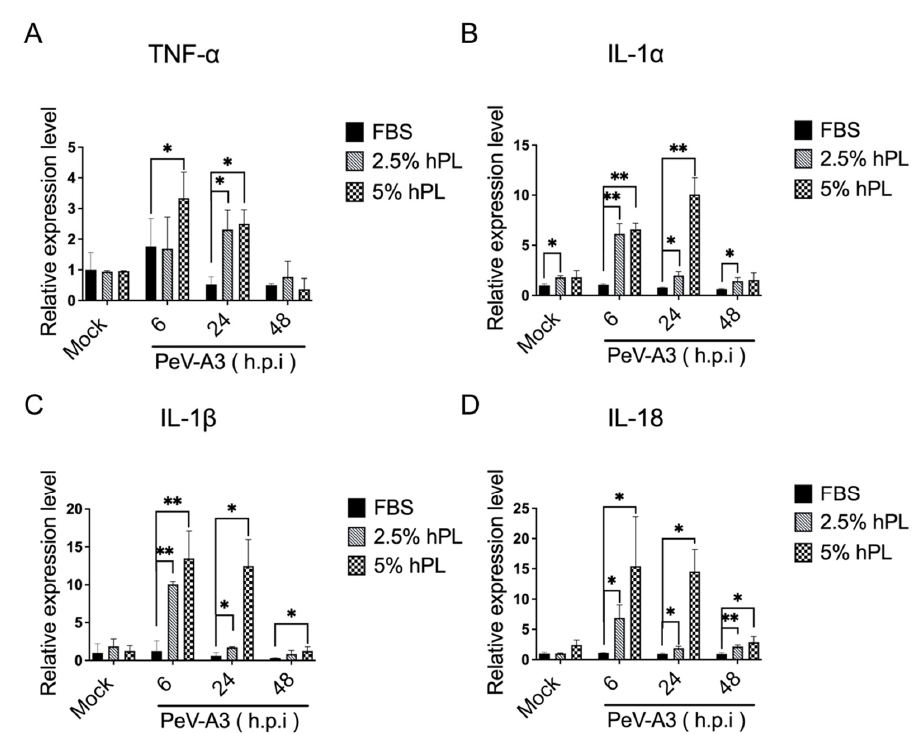
Figure 5. ( A – D ) hPL-supplemented growth medium-induced inflammatory cytokines under PeV- A3 infection of GBM cells. Inflammatory cytokines IL-1 α , IL-1 β , IL18, and TNF- α were analyzed using real-time qPCR. Data are mean ± SD of three independent samples. Student’s t -test, *, p < 0.05; **, p < 0.01 compared with FBS. **, p < 0.01 compared with